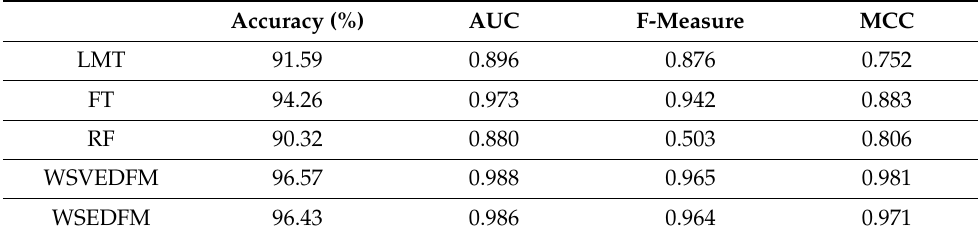
Table 10. The CCP performance of DF models and their Enhanced ensemble variants on balanced Dataset